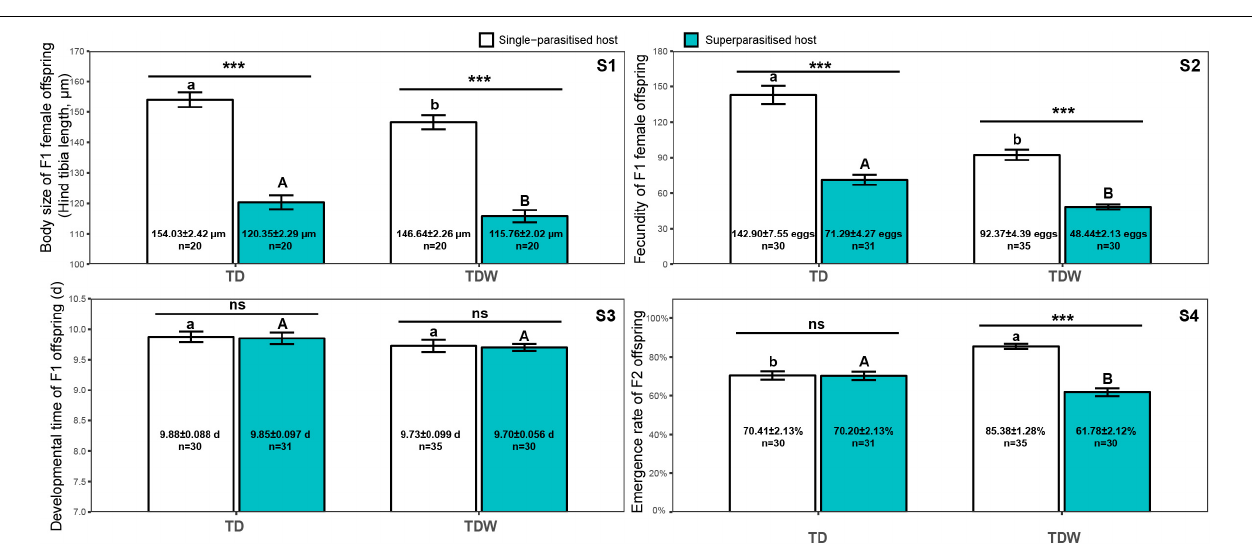
Frontiers in Ecology and Evolution |